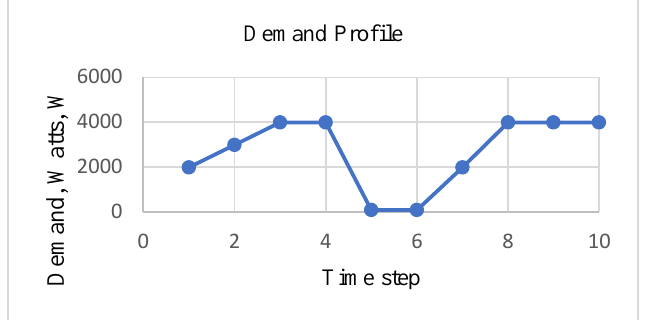
Figure 1. Demand profile.